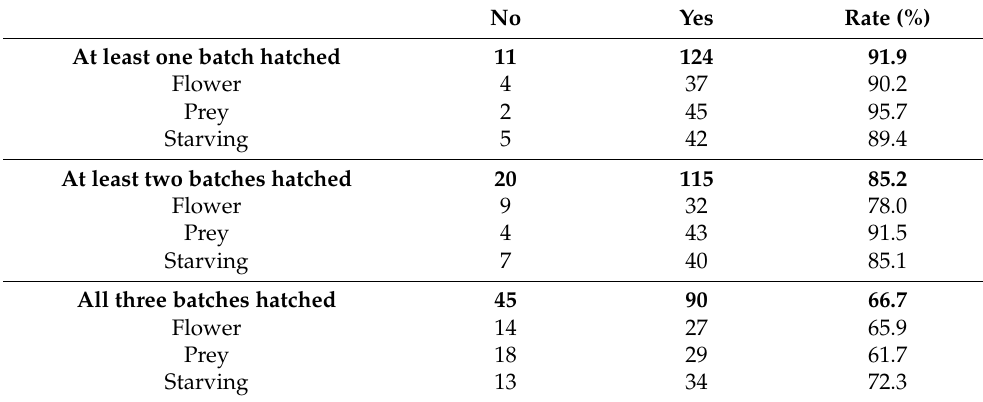
Table 1. Number of Harmonia axyridis females producing viable and not viable egg batches (i.e., Yes: hatched egg batch; No: not hatched egg batch), and rate of females producing viable egg batches over the total number of ovipositing females (in percentage), according to the diet they received at eclosion. A maximum of three batches were collected from each female.